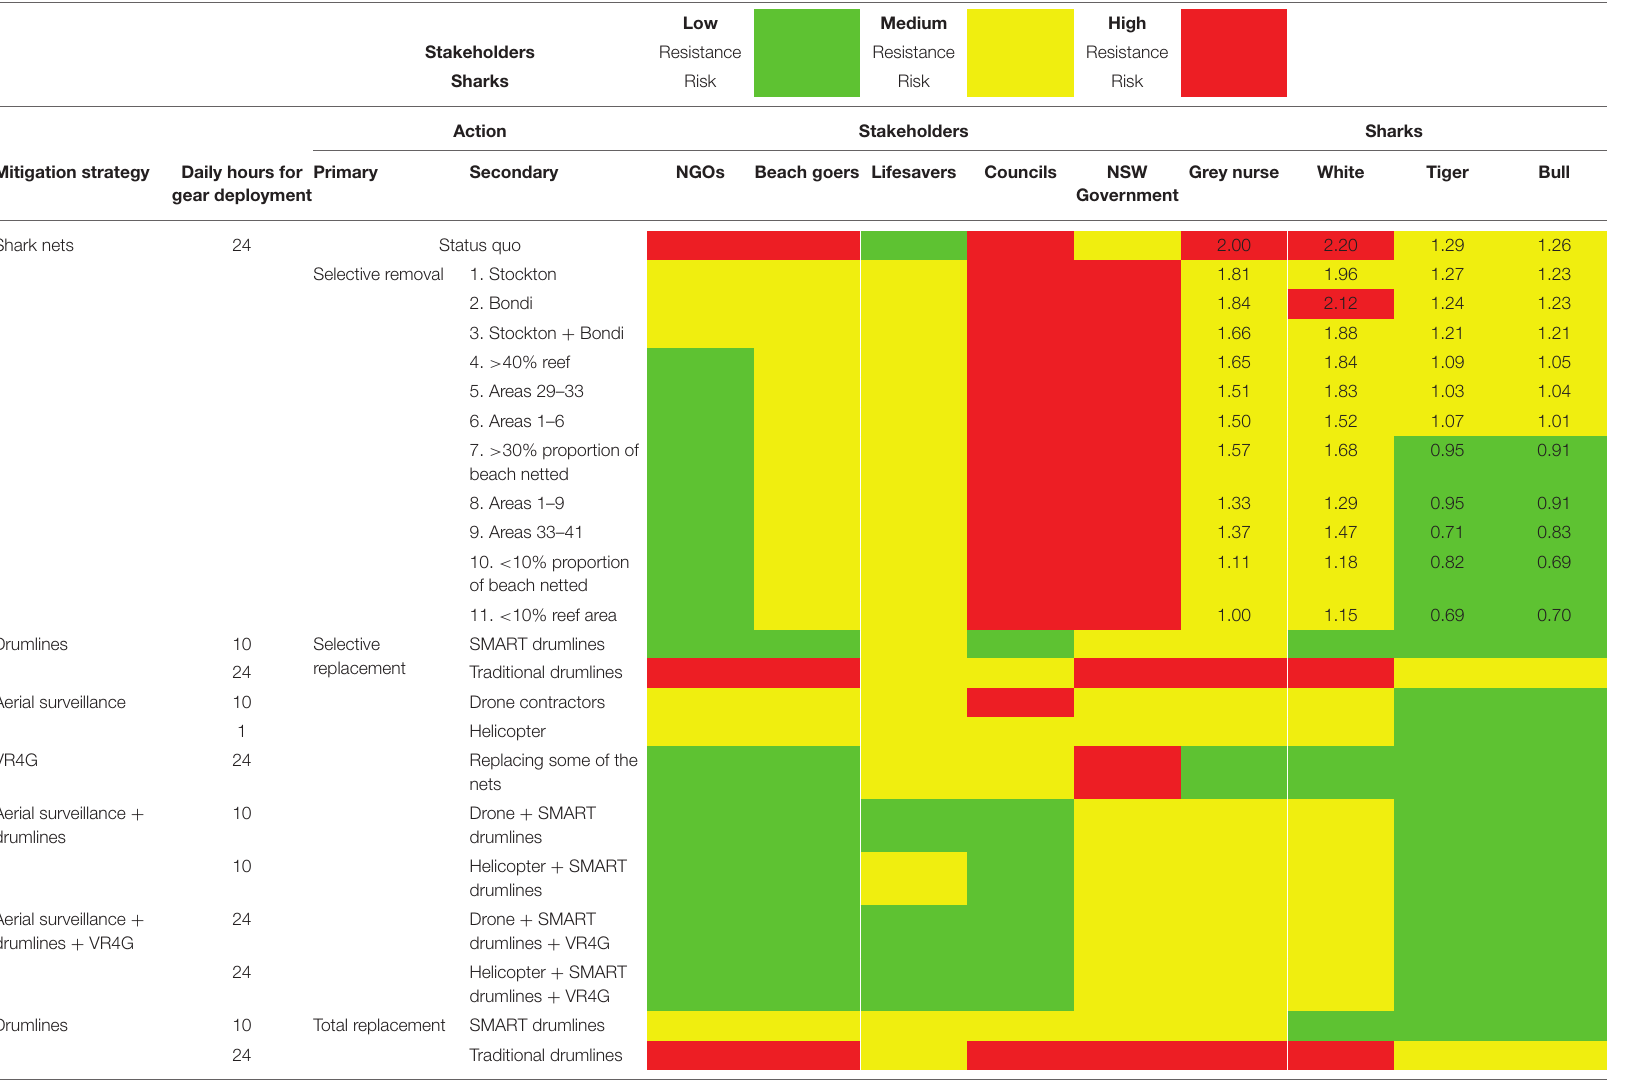
TABLE 2 | Wicked problem matrix originated from the Shark Meshing Program, comprising a series of possible actions to the program and the expected outcomes for each stakeholder group and consequent risk for the shark species